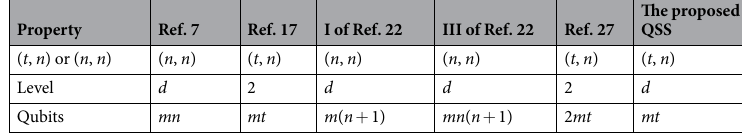
Table 1. Comparison of universality and practicability.